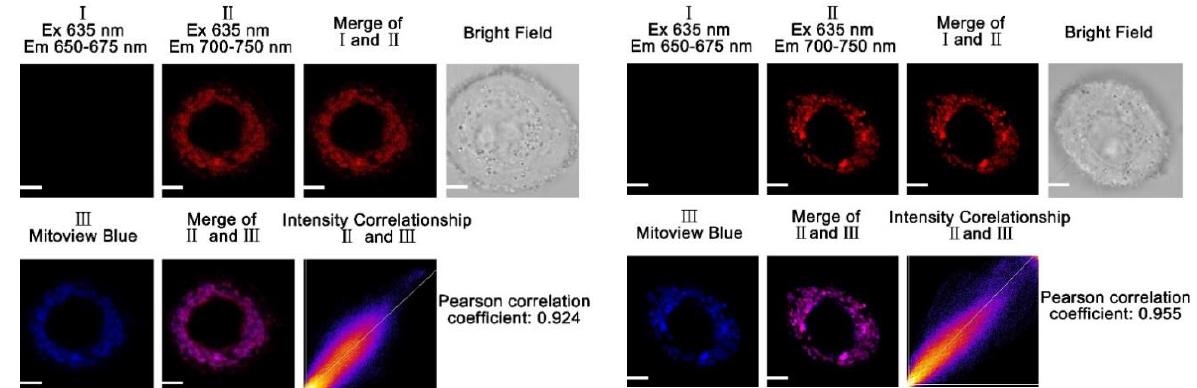
Figure 13. Fluorescence images of HeLa cells incubated with 10 µM probes AH + ( left ), BH + ( right ), and 5.0 µM Mitoview Blue. The first and second channels in the fluorescence images were recorded from 650 nm to 675 nm, and from 700 nm to 750 nm under excitation at 635 nm, respectively. The third channel in the images was collected from 425 nm to 460 nm under excitation of 405 nm. Scale bars: 10 µm. HeLa cells were incubated with 10 µM probe AH + or BH + in media at 37 °C for 20 min. Live-cell images were obtained by an Olympus IX 81 confocal microscope.